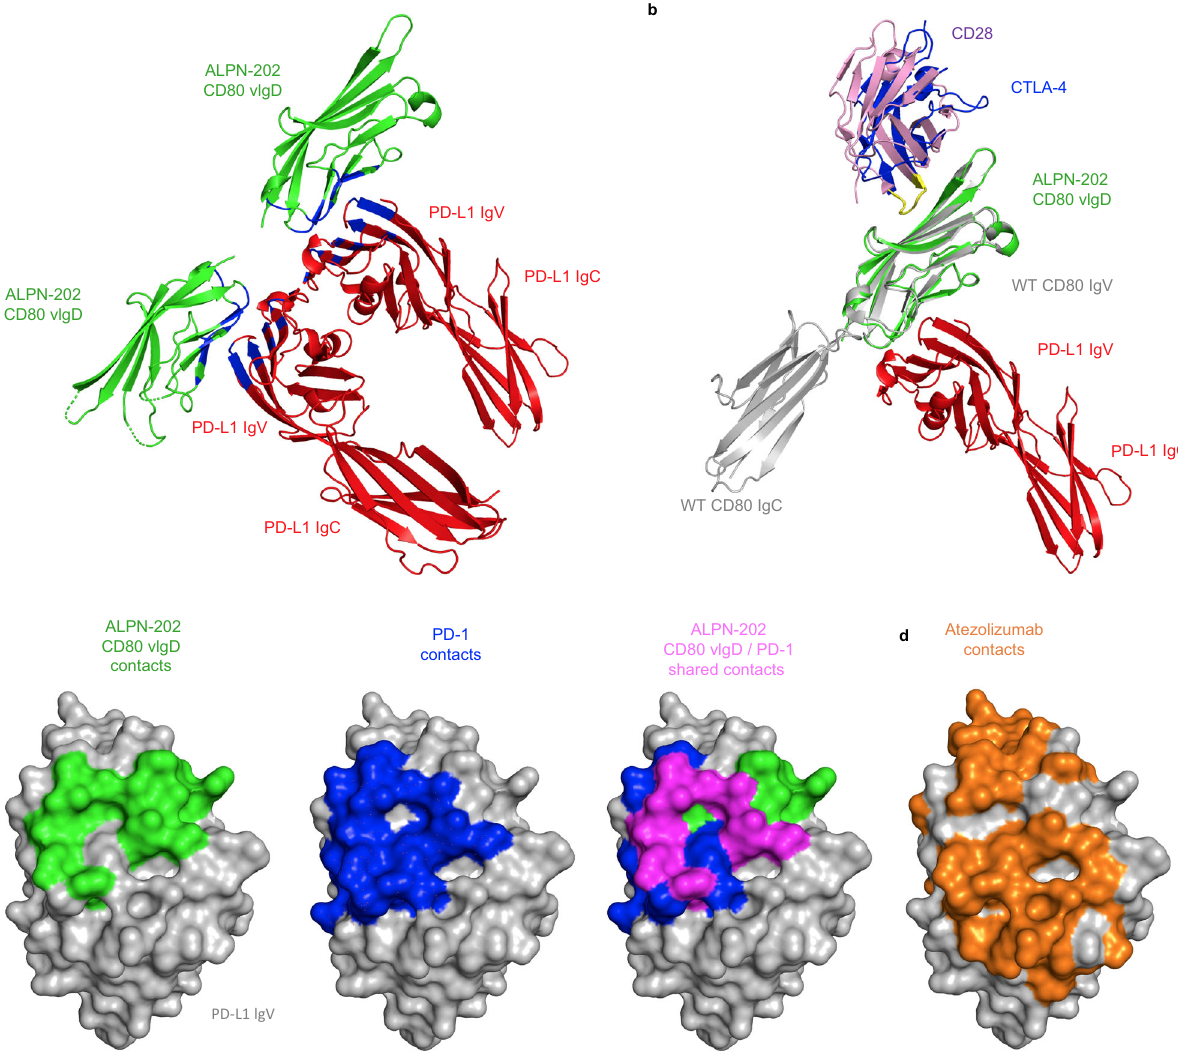
Fig. 3 Crystal Structure of ALPN-202 CD80 vIgD complexed with the wild type PD-L1 ECD. a Representative ribbon structure from the ALPN-202 CD80 variant Ig domain (vIgD) (green) and wild type (WT) PD-L1 extracellular domain (ECD) (red) crystal structure with the interface contact residues indicated in blue (PDB: 7TPS) b Model alignments of one subunit (Chain A and Chain B) of the ALPN-202 CD80 vIgD (green)/PD-L1 ECD (red) asymmetric unit aligned with wild type CD80 ECD (gray)/CTLA-4 ECD (blue) (PDB: 1I8L) and CD28 (pink) (PDB: 1YJD). The CD28 and CTLA-4 MYPPPY motifs are indicated in yellow. c Comparison of ALPN-202 CD80 vIgD binding contacts in green, PD-1 binding contacts in blue (PDB: 4ZQK) and ALPN-202 and PD-1 common contacts indicated in magenta mapped onto the surface of PD-L1 IgV domain (gray). d Atezolizumab (orange) contacts mapped to the same surface as PD-1 and ALPN-202 CD80 vIgD contact residues on the surface of PD-L1 IgV